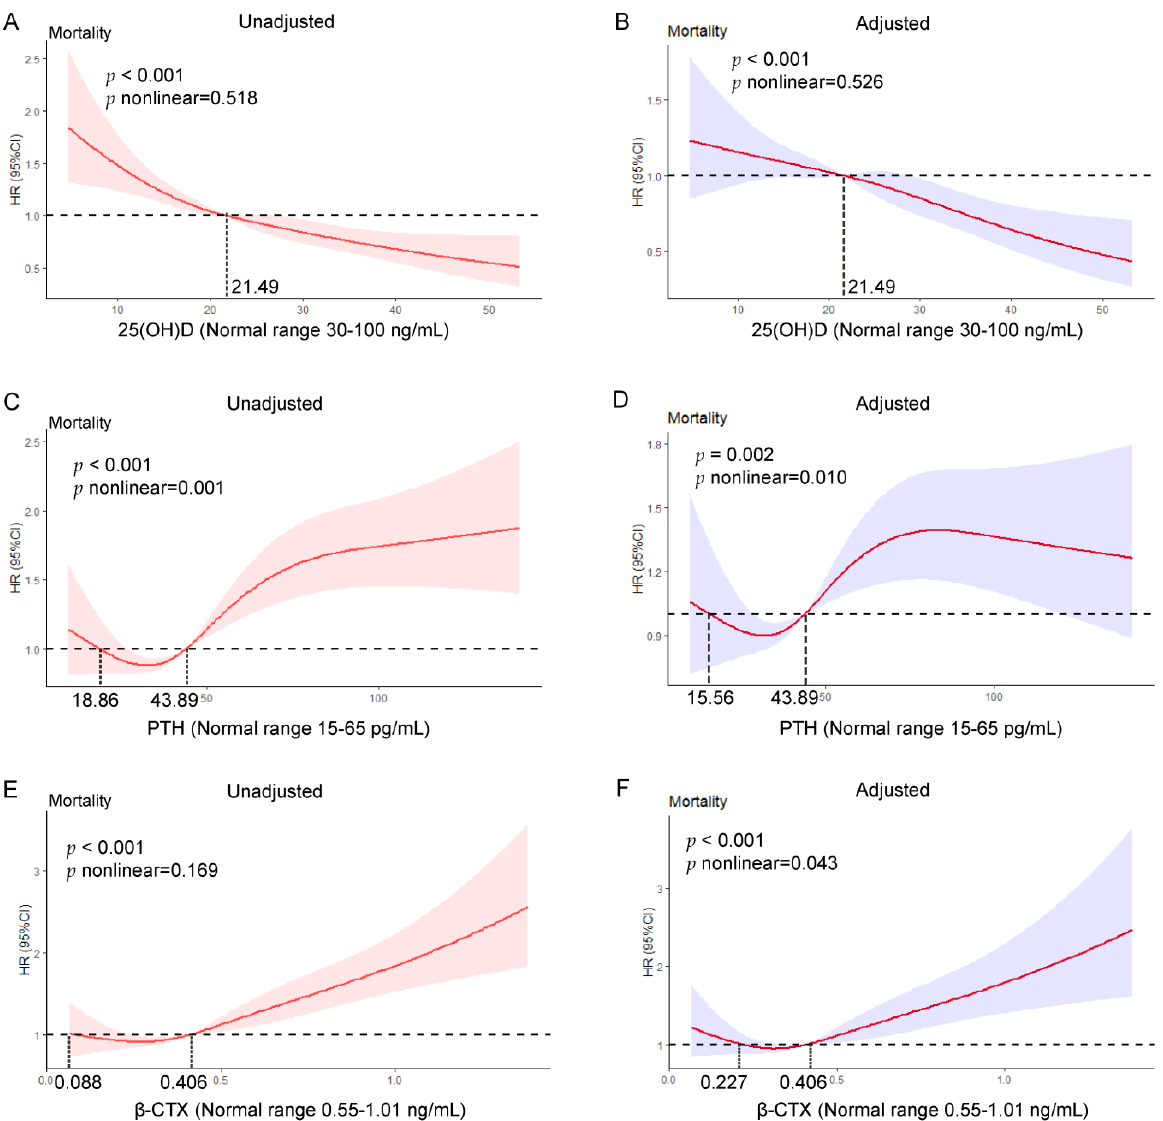
Figure 3. Unadjusted and adjusted associations of serum 25(OH)D, PTH, and β-CTX levels with all- cause mortality in Cox models with restricted cubic spline (RCS) analyses. The solid red line indicates the hazard ratio, and the shaded areas represent the 95% CI. The relationship between 25(OH)D and mortality was linear in both unadjusted ( A ) and multivariable-adjusted models ( B ); The relationship between PTH and mortality was approximately J-shaped in both unadjusted ( C ) and multivariable-adjusted ( D ) models. For centenarians with a PTH level in the range of 15.56–43.89 pg/mL, the risk of all-cause mortality reached a nadir, with a significant positive association above but a non-significant negative association below this range. The relationship between the β -CTX level and mortality was nearly linear in the unadjusted model ( E ) but J-shaped in the multivariable-adjusted model ( F ). For centenarians with a β -CTX level of 0.227–0.406 ng/mL, the risk of all-cause mortality reached a nadir, with a significant positive association above but a non-significant negative association below this range. It should be noted that centenarians with β -CTX levels in the clinical reference range (0.55–1.01 ng/mL) did have a significantly increased mortality. The data are adjusted for demographic factors (age, sex), body mass index, lifestyle factors (cigarette smoking, alcohol consumption, outdoor activities), comorbidities (incidence of hypertension, diabetes mellitus, cardiovascular disease), past medical history (fractures, surgery), and other possible confounding factors (serum creatinine, hemoglobin, C -reactive protein, homocysteine, and low-density lipoprotein cholesterol levels). 25(OH)D, 25-hydroxyvitamin D; β -CTX, β - C -terminal telopeptide of type 1 collagen; HR, hazard ratio; PTH, parathyroid